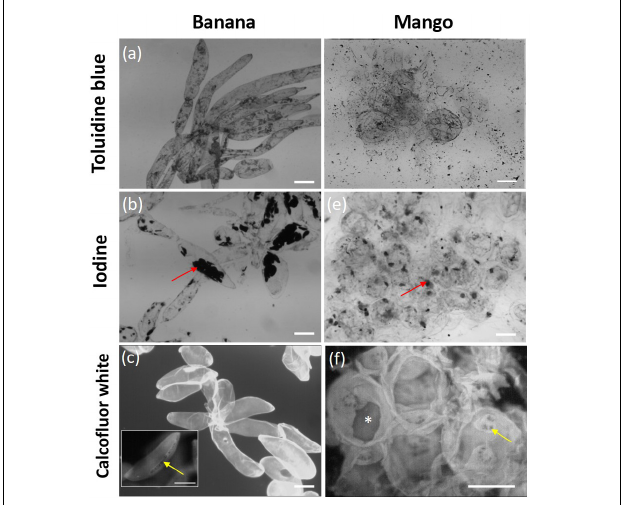
FIGURE 1 | Micrographs of banana cells stained with toluidine blue (a) , iodine (b) and calcofluor white (c) ; and mango cells stained with toluidine blue (d) , iodine (e) and calcofluor white (f) . Scale bar = 100 µ m. Red arrows point to starch granules clearly visible in banana, yellow arrows point to the location of pit fields in strips in banana and round pits in mango. ∗ Indicates tearing of the cell wall in mango fruit.